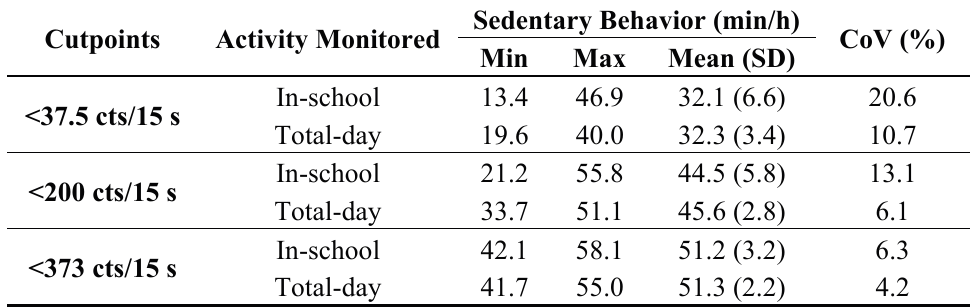
Table 2. Minimum, Maximum, Mean (SD), and Coefficient of Variance of Sedentary Behavior.